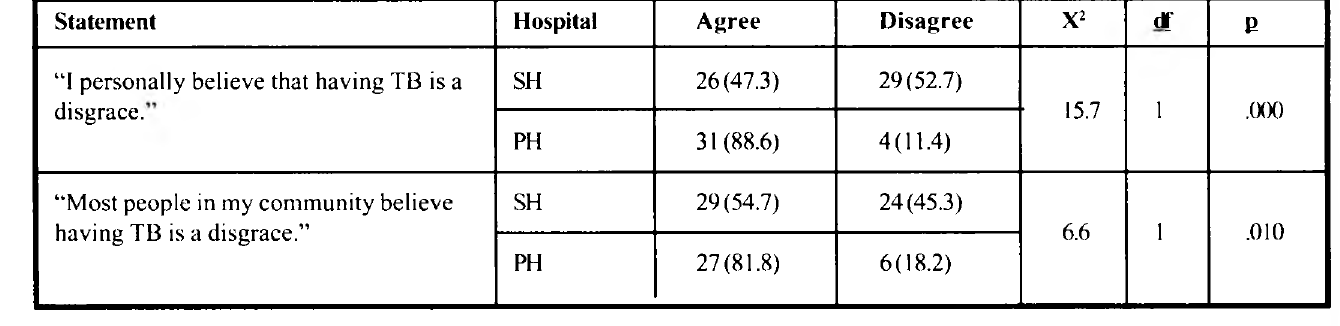
Table 7: TB hospital patients’ views of stigmatisation of TB